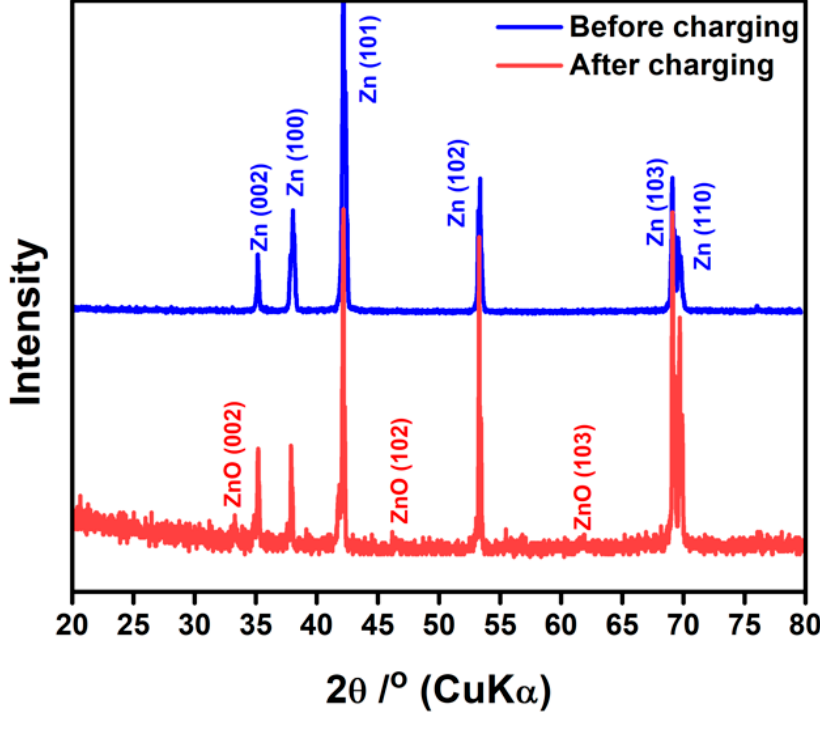
Figure 8. X-ray diffraction patterns for Zn foil before and after charging.